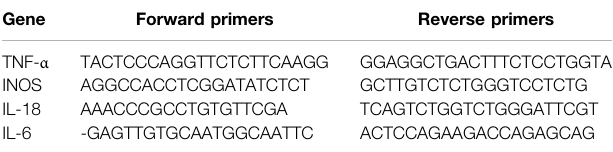
TABLE 1 | The primer sequences used for real-time PCR.